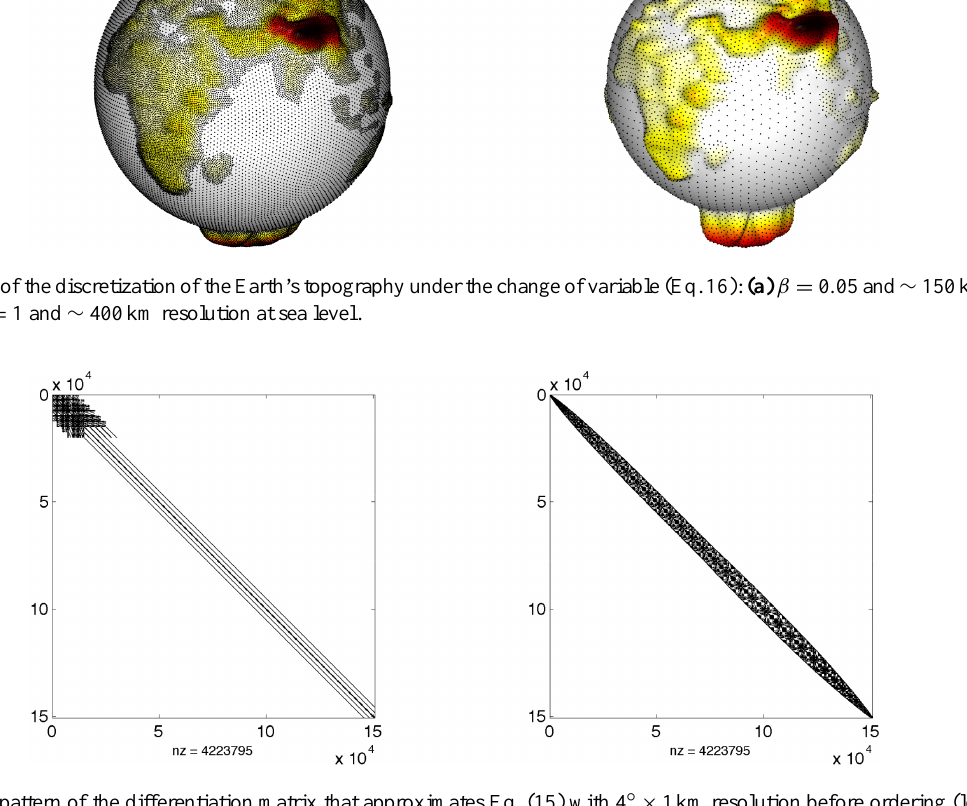
Figure 3. Sparsity pattern of the differentiation matrix that approximates Eq. (15) with 4 ◦ × 1km resolution before ordering (left) and after applying sparse reverse Cuthill–McKee ordering